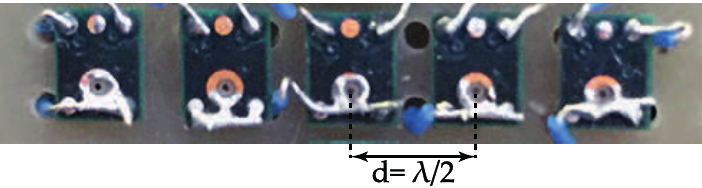
Figure 8. Setup of the experimental microphone array with an inter-element spacing (d) of approximately λ /2 where λ is the wavelength of a 40 kHz acoustic wave. Each microphone is a SPU0410LR5H-QB [18] Micro-Electromechanical Systems (MEMS) omnidirectional